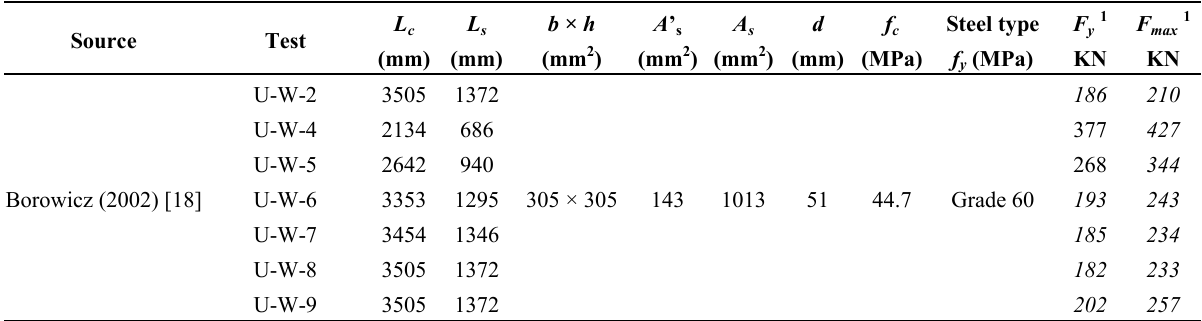
Table 1. The geometry and mechanical properties of considered test specimens and main